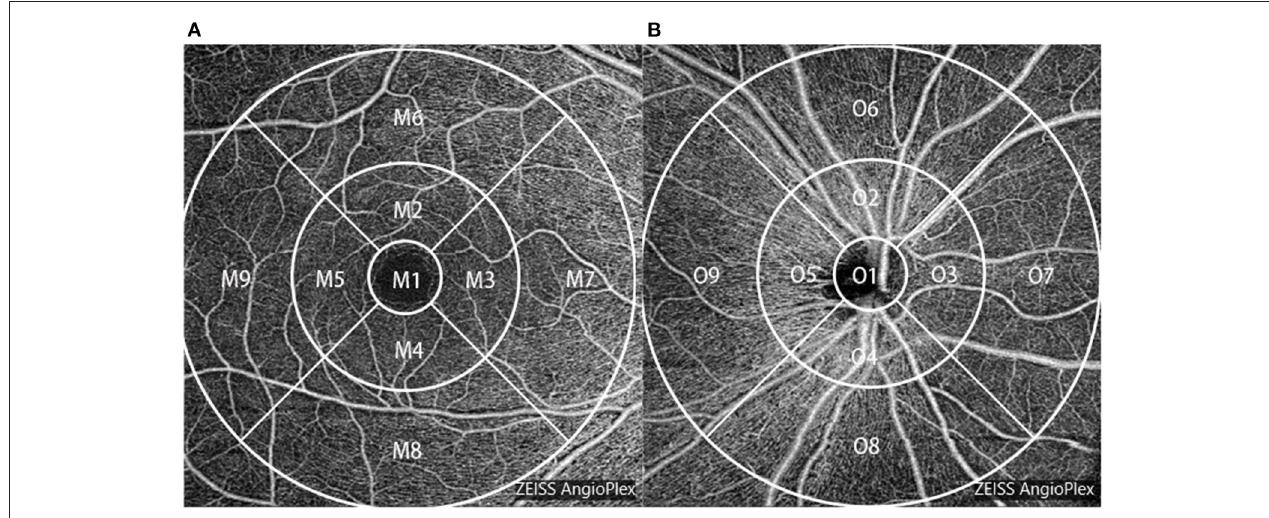
FIGURE 2 | Vessel density map of the macula (A) and the optic disc (B) of the right eye based on optical coherence tomography angiography (OCTA).